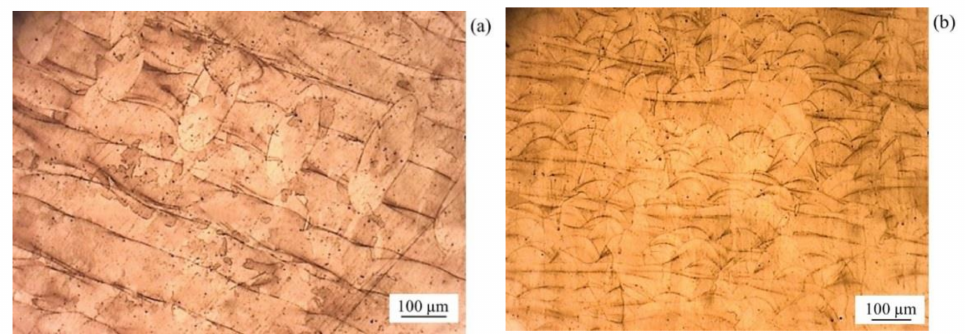
Figure 4. Top view ( a ) and cross-section ( b ) of 316 L steel manufactured by L-PBF